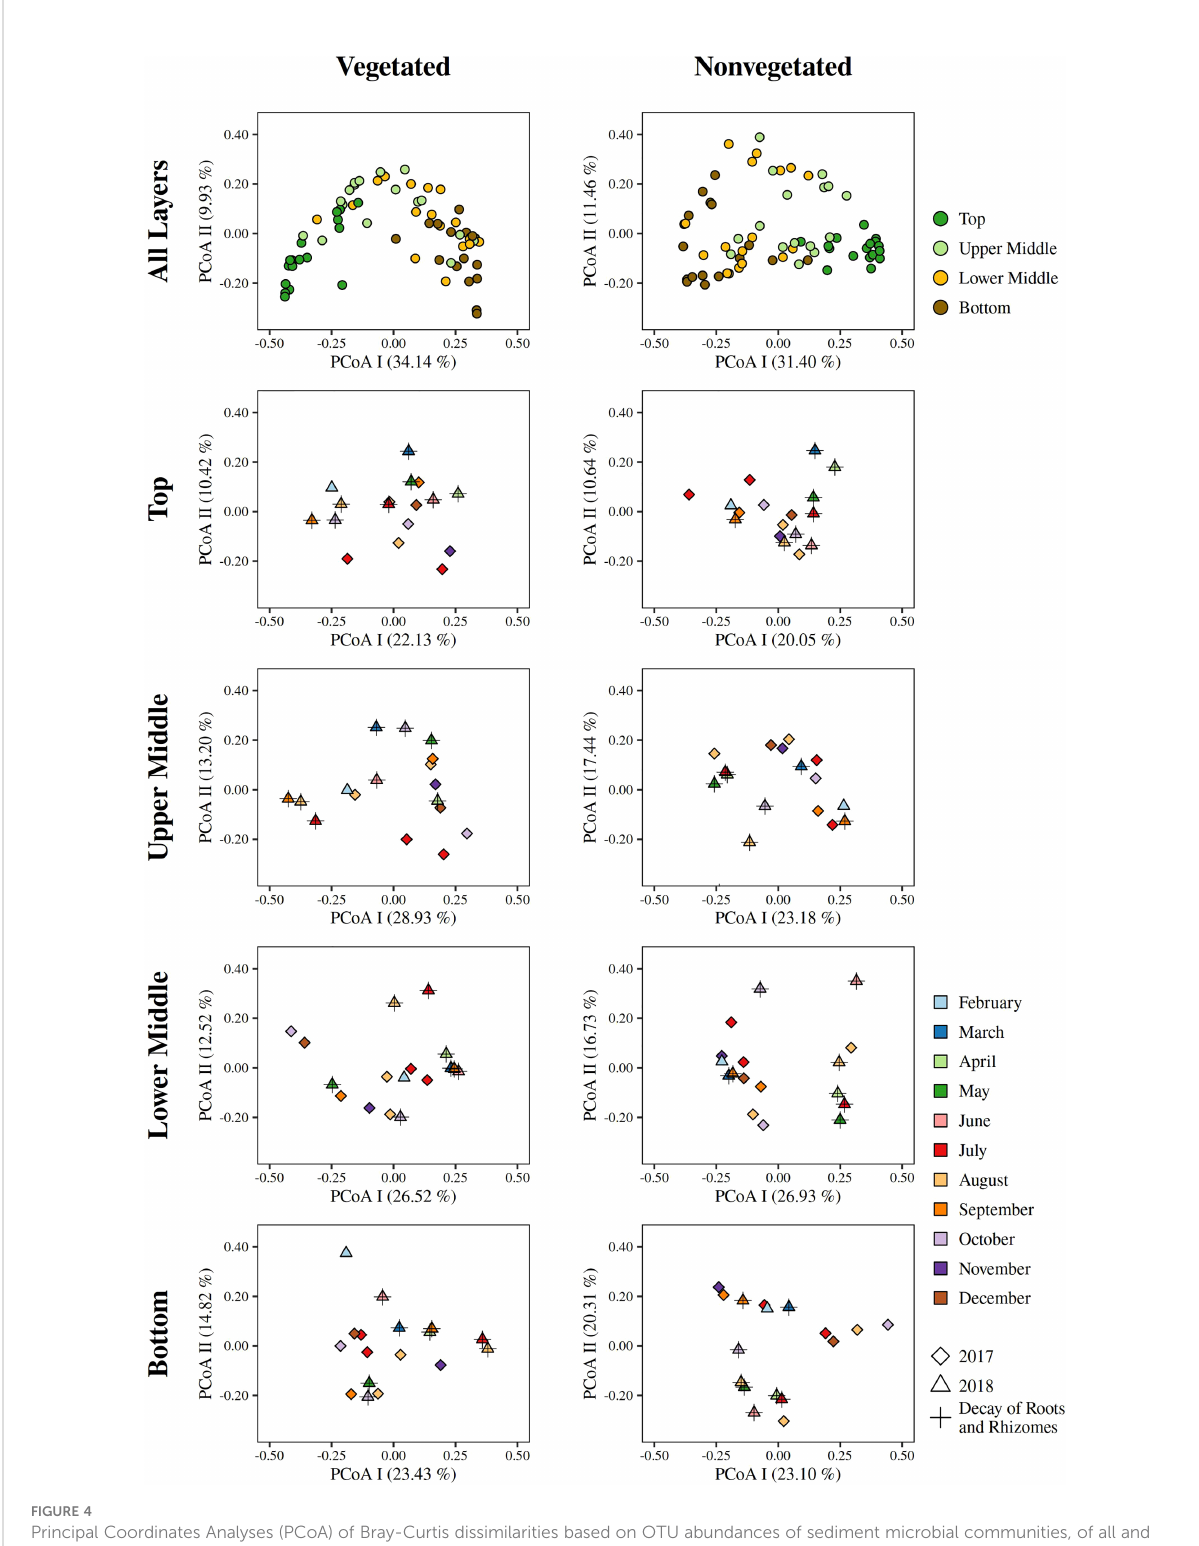
FIGURE 4 Principal Coordinates Analyses (PCoA) of Bray-Curtis dissimilarities based on OTU abundances of sediment microbial communities, of all and individual sediment layers, sampled at the vegetated and nonvegetated site in the Bay of Saline. The proportion of explained variation by each axis is shown on the corresponding axis in